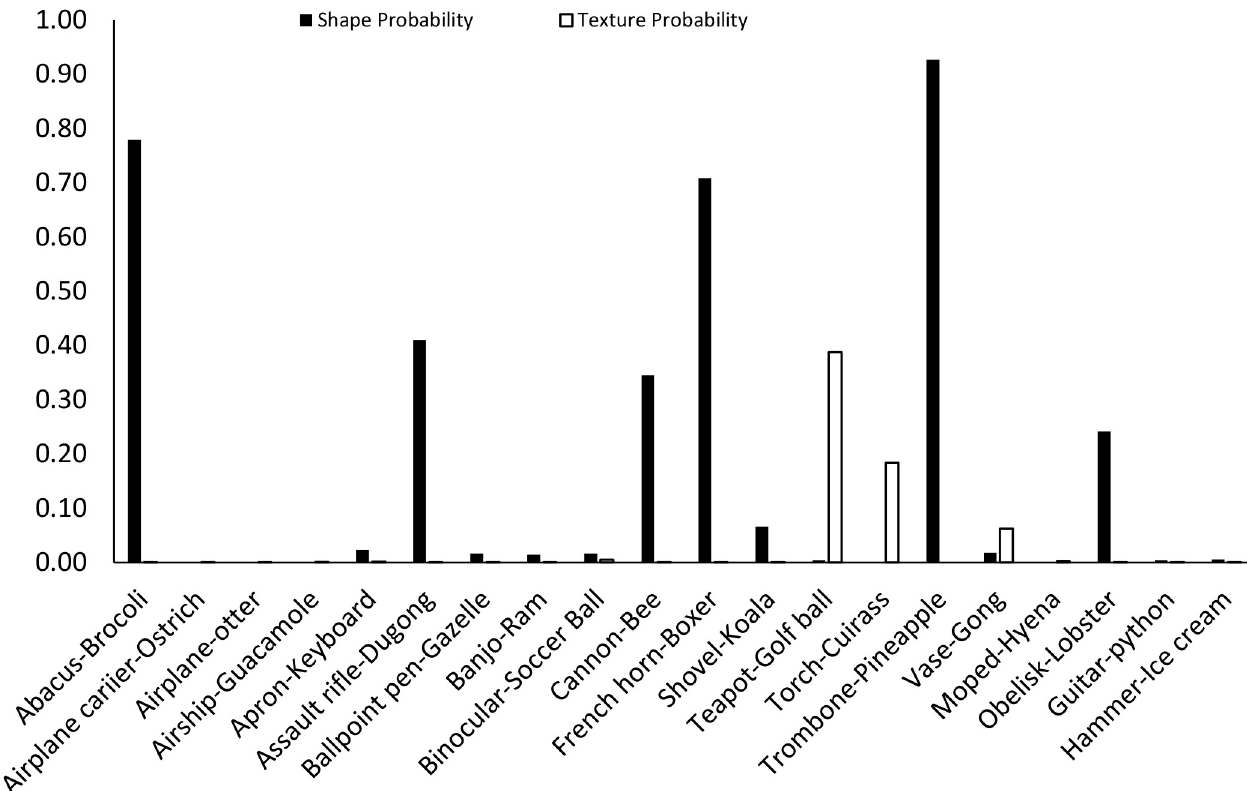
Fig 8. Comparison of probabilities assigned to image shapes and textures for artifacts. On the x-axis, the shape and texture of each object are given as shape-texture. Filled black bars display the probability given by the network to the correct shape. Outlined bars display the probability given by the network for the correct